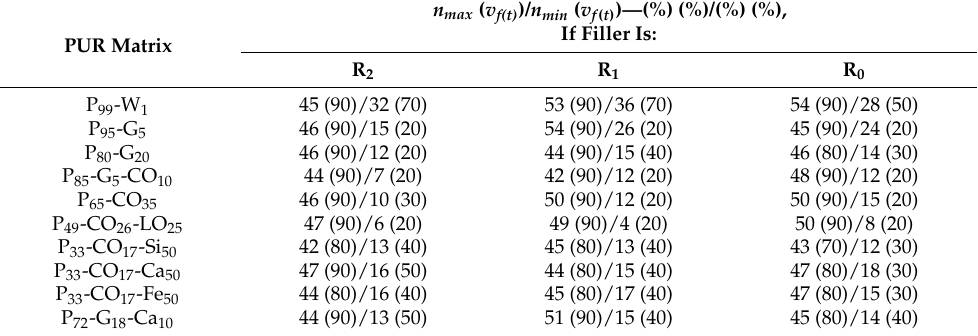
Table 5. Maximal and minimal values of porosity ( n max , n min ) in composites for all combinations of matrices and rubbery fillers with mentioned corresponding volume fractions of filler ( v f ( t ) — theoretical value meaning neglecting of porosity). Porosity values are averages from measurement of five samples.